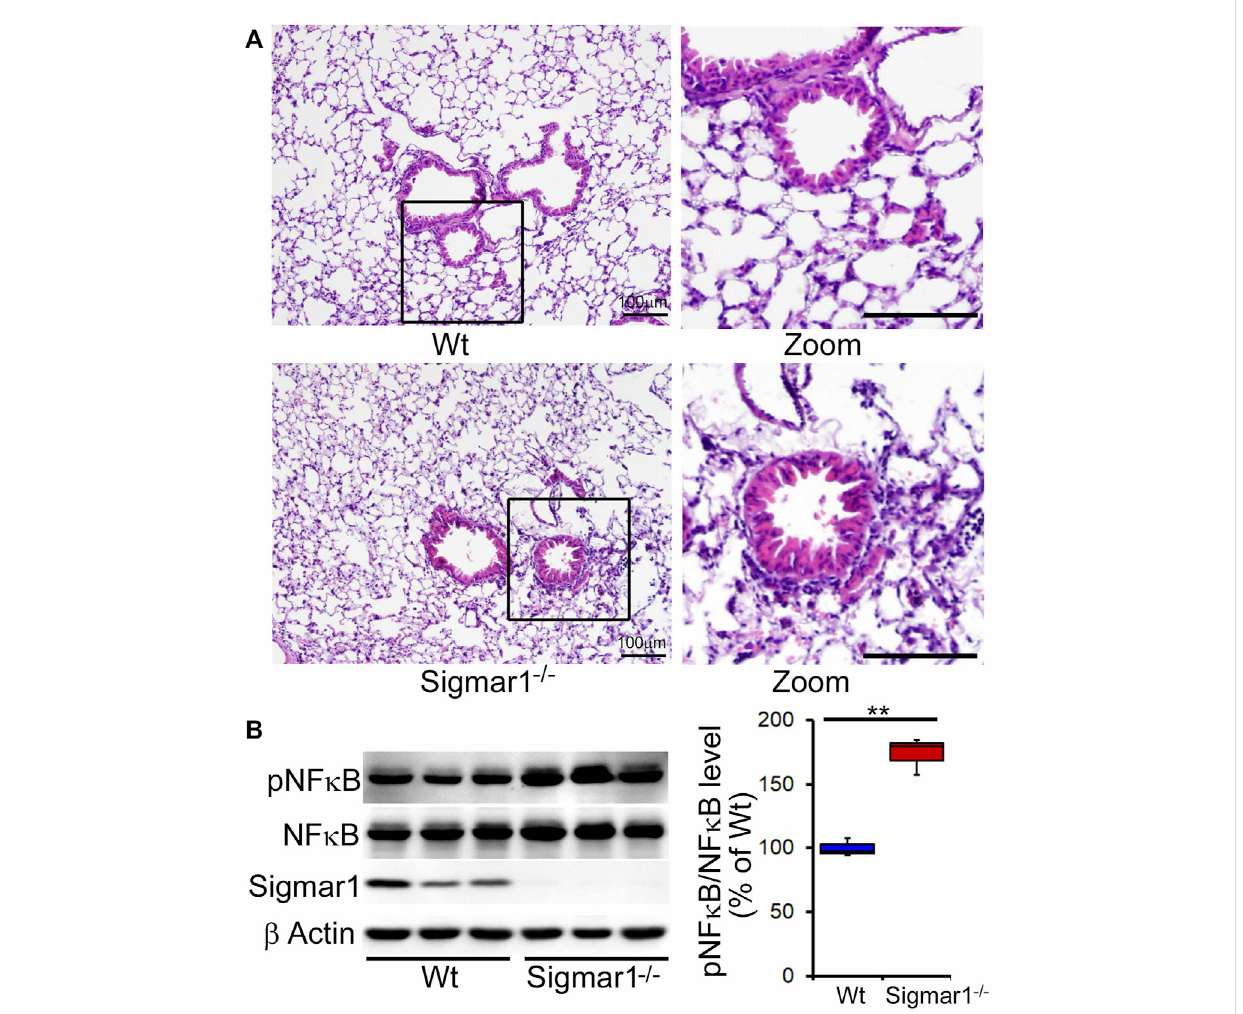
FIGURE 2 Altered alveolar structures and increased pulmonary in fl ammation in aged Sigmar1 − / − mouse lung. Lungs from aged mice were isolated, and paraf fi n- fi xed tissue sections were stained for hematoxylin and eosin (H&E). (A) H&E staining of lung tissue sections showed altered alveolar structures and increased immune cell in fi ltration in Sigmar1 − / − mouse lungs compared to age-match littermate Wt mouse lungs (n = 3 per group). Scale bars: 100 µm; (B) Westernblotimages and quanti fi cations showing increased NF κ B phosphorylationin aged Sigmar1 − / − mouse lungs compared to age match littermate Wt mouse lungs (n = 3). The Kruskal – Wallis test determined p values, and p < 0.05 was considered statistically signi fi